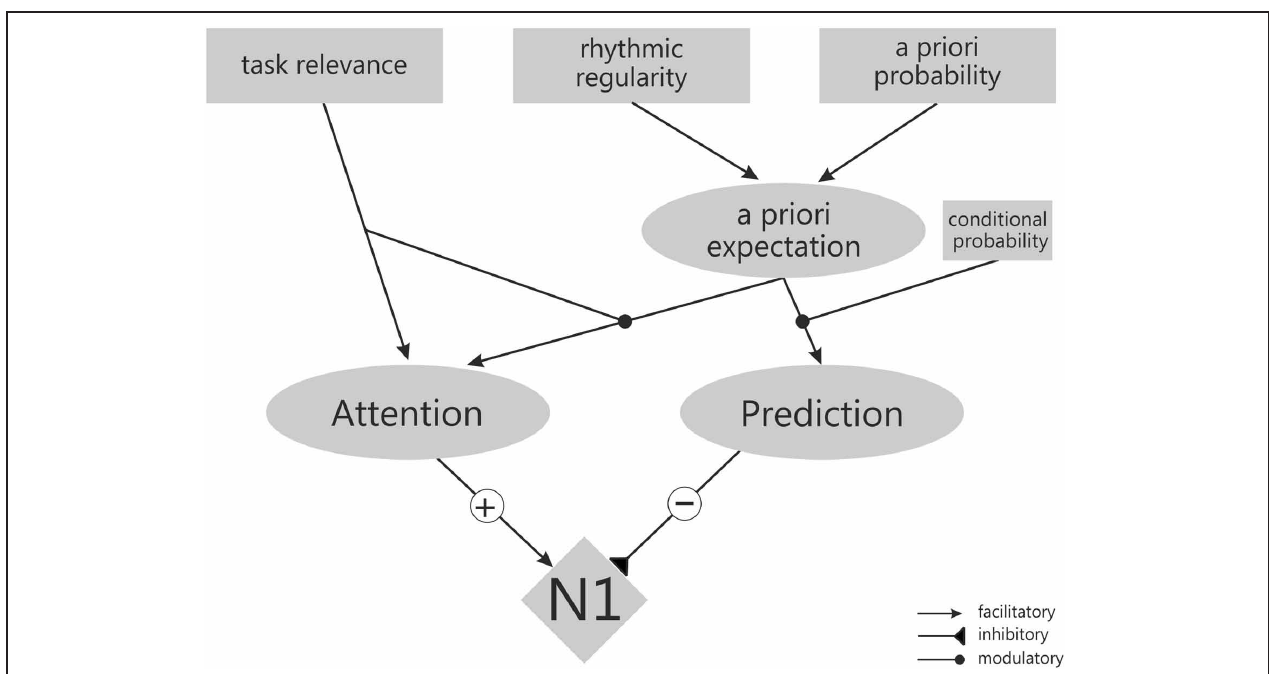
FIGURE 4 | Schematic outline of the components (gray boxes) and relations (black lines) assumed by the working model explaining N1 amplitude by opposite effects of attention and predictability.